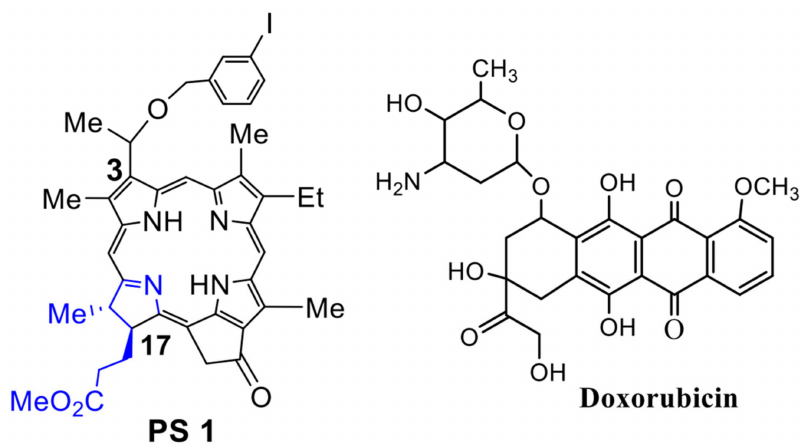
Figure 1. Doxorubicin, a chemotherapy agent [32] routinely used for the treatment of lung cancer patients, was purchased from Sigma Aldrich,